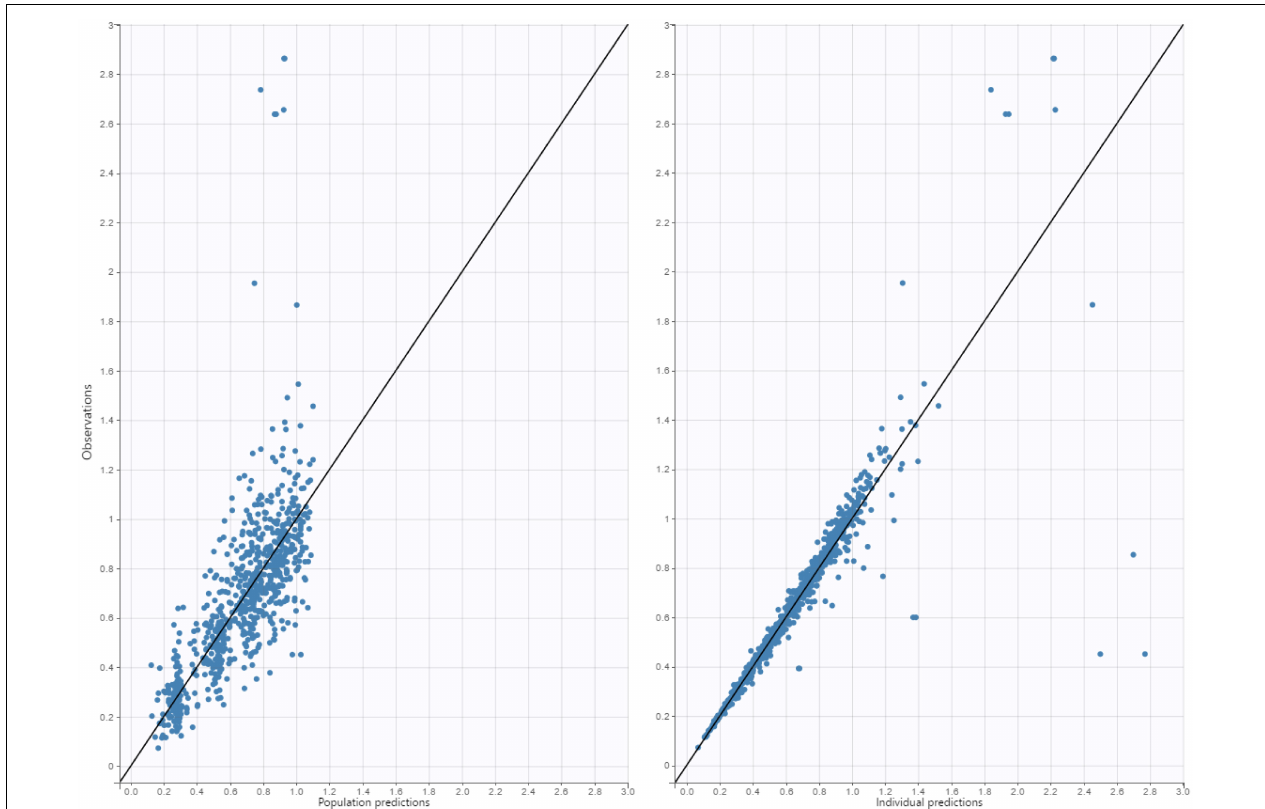
FIGURE 1 | Goodness-of-fit plot for final population pharmacokinetic model. Right: Individual predictions of busulfan vs. observed concentrations. Left: Population predictions of busulfan vs. observed concentrations.